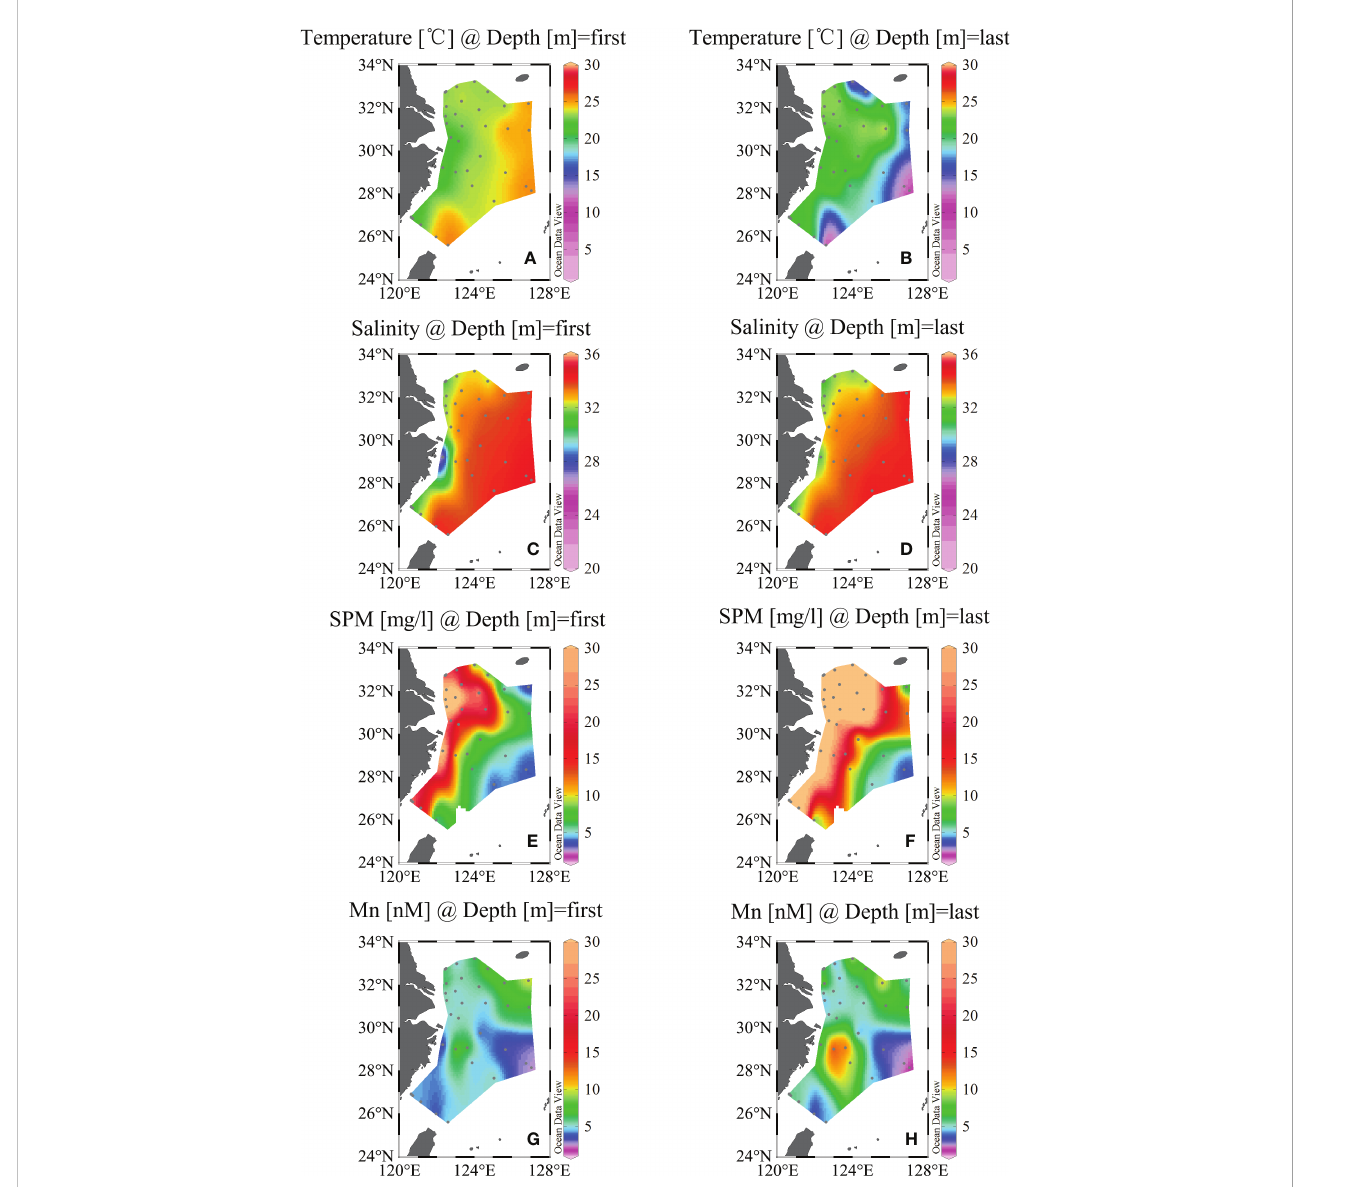
FIGURE 5 Horizontal distributions of temperature (°C), salinity, SPM (mg/L), and dissolved Mn (nM) in the surface (A, C, E, G) and the bottom layers (B, D, F, H) in the East China Sea in October